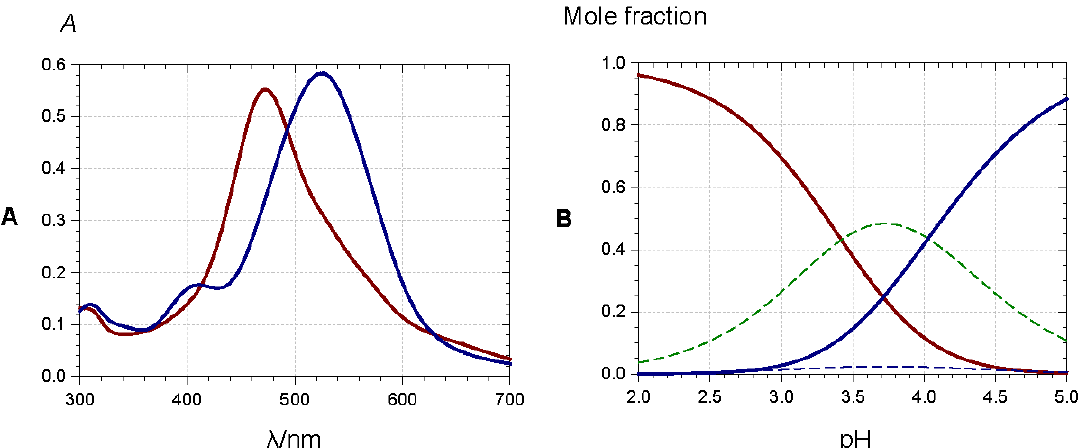
Figure 15. ( A ) 3′,4′-Dihydroxy-7- O -β- D -glucopyranosyloxyflavylium (50 µM) in a pH 4 buffer (0.1 M acetate), red spectrum: before hydration, blue spectrum: 10 min after addition of Al 3+ (4 equiv.); ( B ) equilibrium distribution of species in aqueous solution. Red solid line: flavylium ion, blue dotted line: neutral base, dotted green line: total colorless forms, blue solid line: Al 3+ complex. Parameters for plots are p K ’ h = 3.42, p K a1 = 4.72, K M = 2 × 10 −4 . From [39].